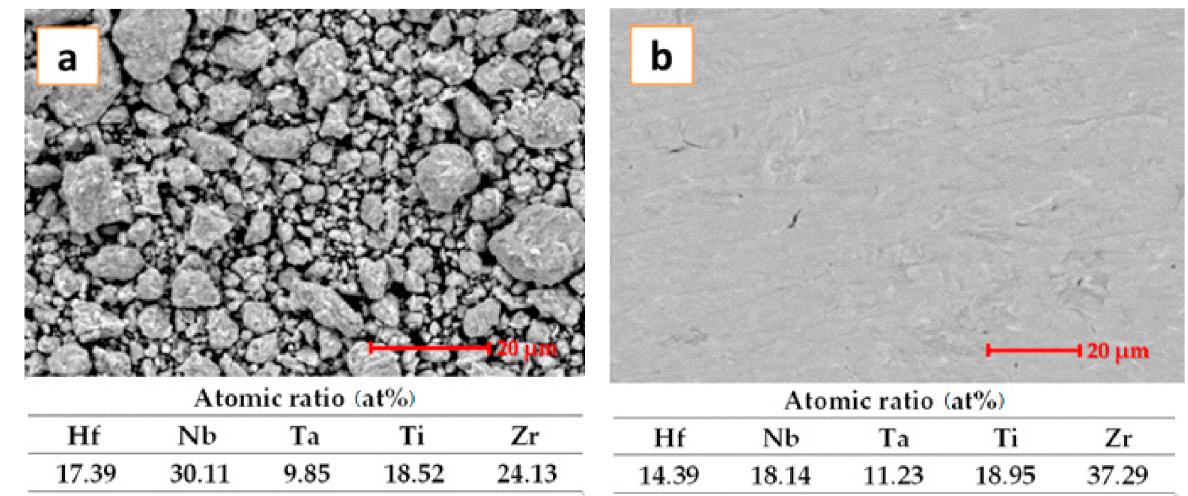
Figure 1. SEM images and EDS analyses of ( a ) mechanically alloyed powder and ( b ) sintered HEA.